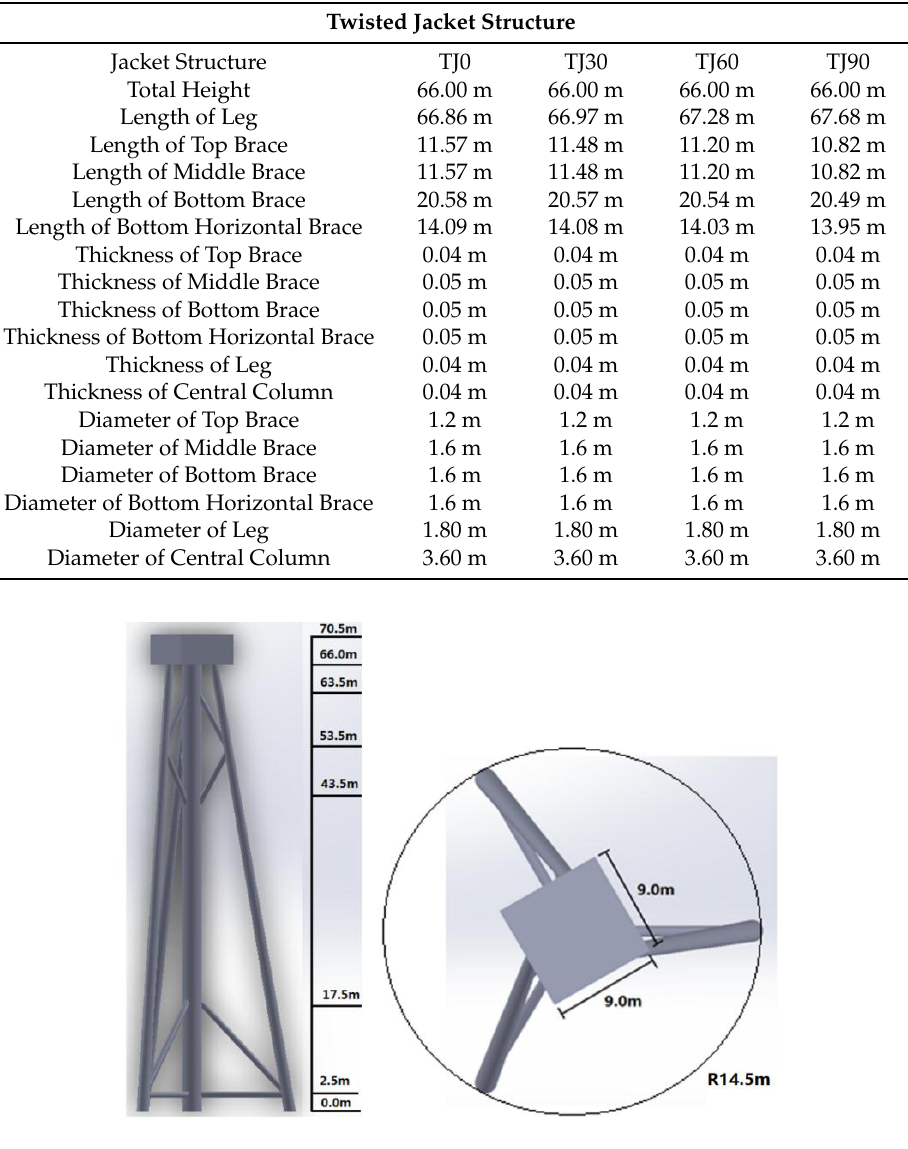
Figure A5. Side and top views of the 0° twisted (TJ30) structure.